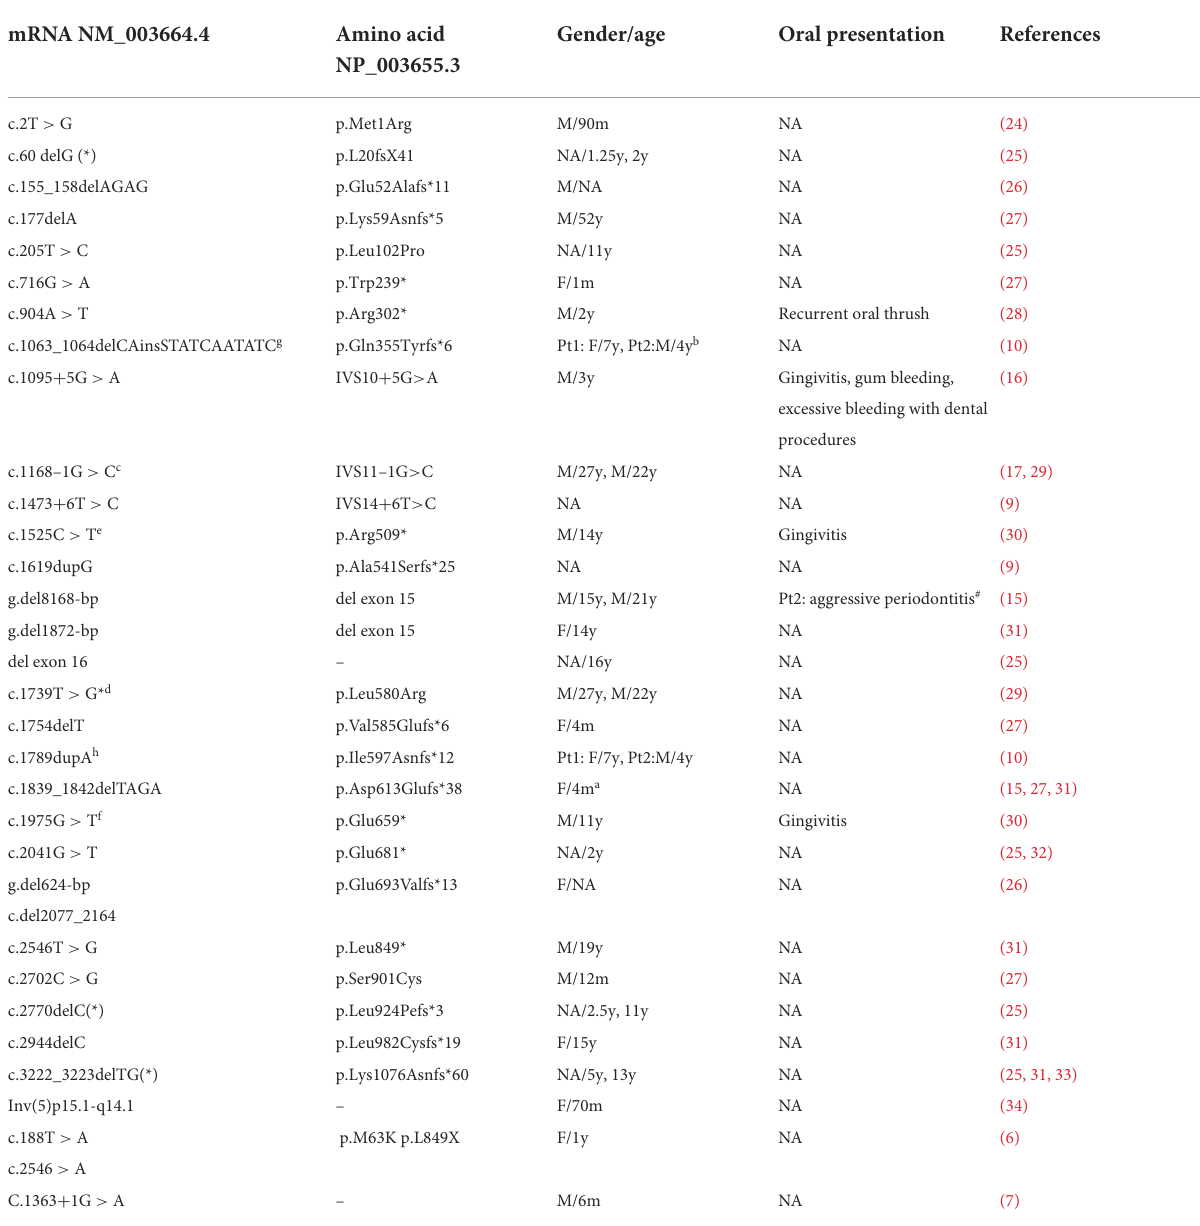
TABLE 2 Reported AP3B1 pathogenic gene variants causing Hermansky-Pudlak syndrome type 2 (HPS-2). mRNA